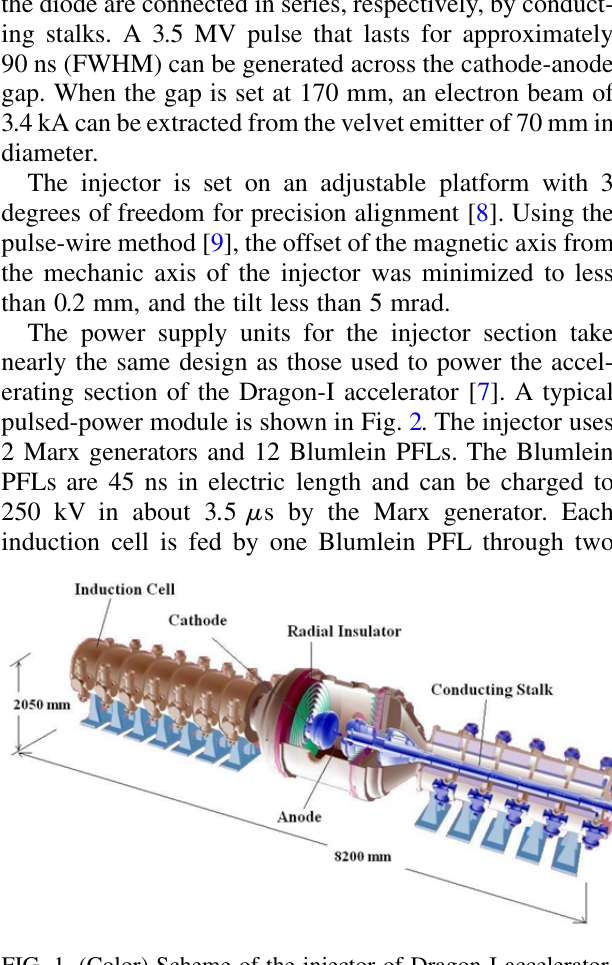
FIG. 1. (Color) Scheme of the injector of Dragon-I